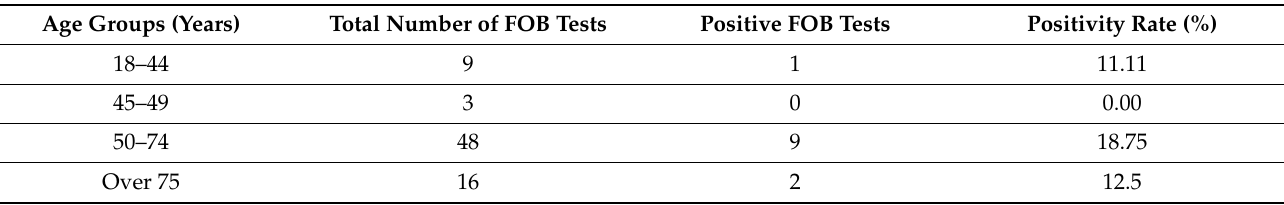
Table 2. The positivity rate of FOB tests by age